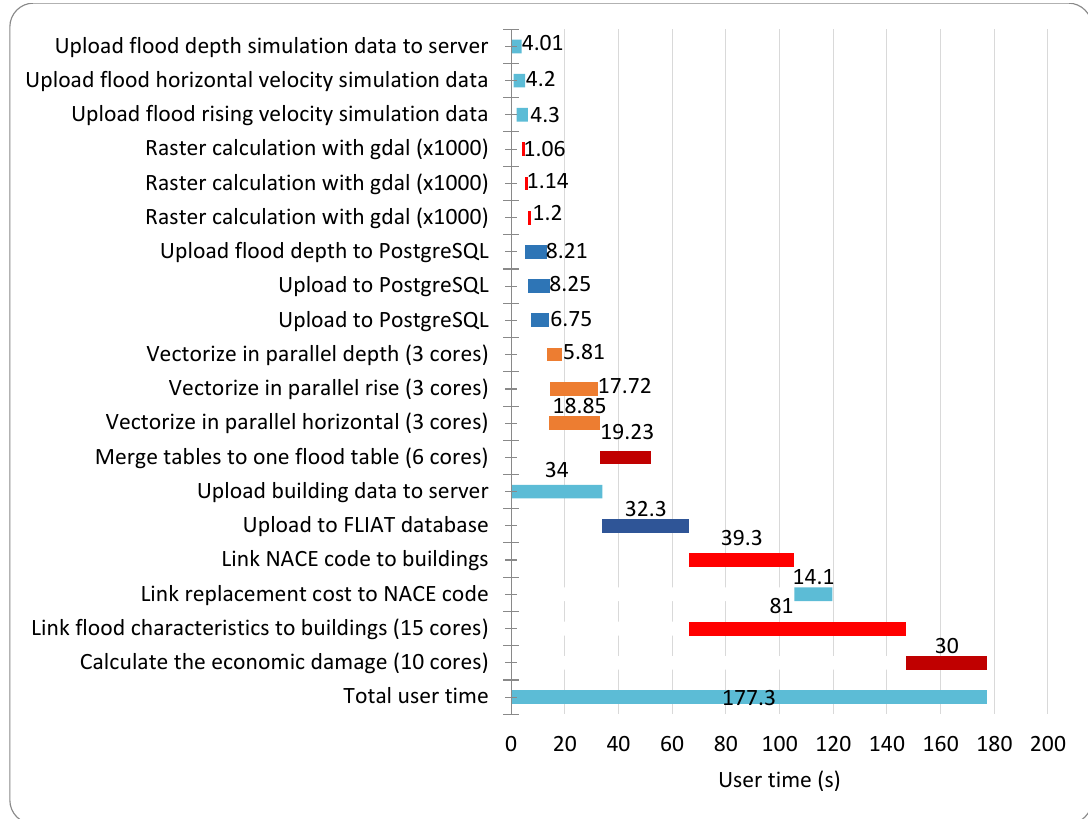
Figure 17. User time to calculate the economic damage of a coast flood event for the Belgian coast with the FLIAT tool.